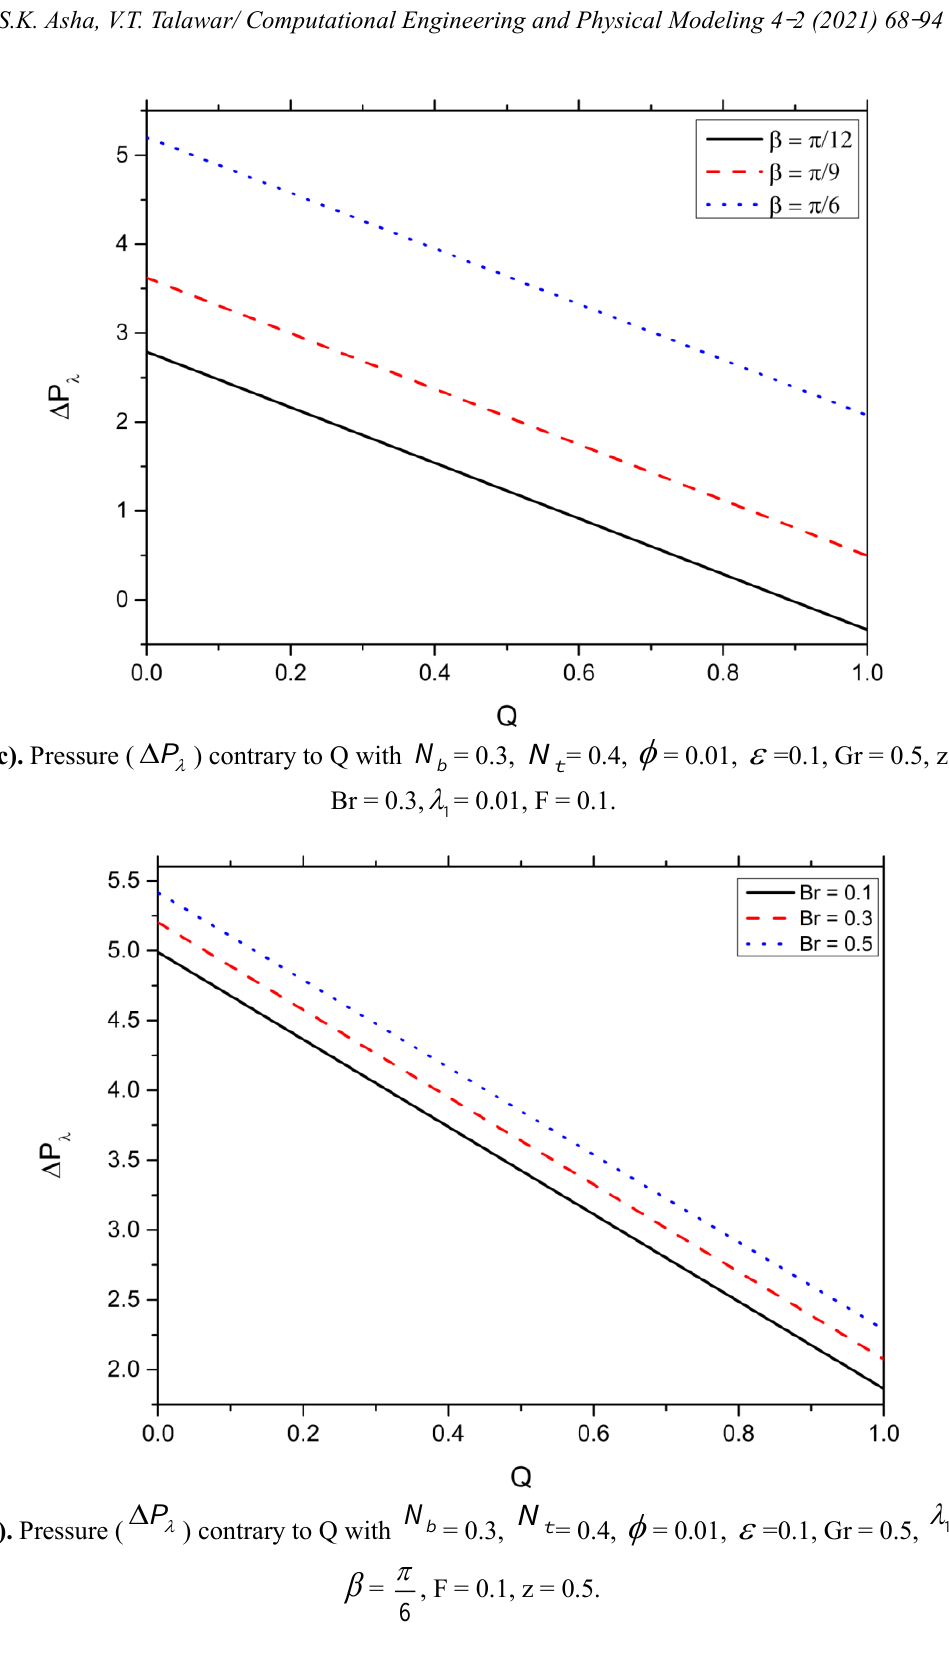
Fig. 2(d). Pressure (